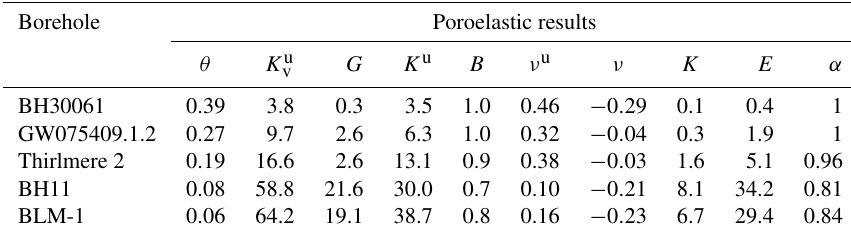
Table 4. Poroelastic results where θ is porosity (–), K u v is the vertical undrained bulk modulus, G is the shear modulus (GPa), K u is the undrained bulk modulus, B is Skempton’s coefficient (–), ν u is the undrained Poisson’s Ratio (–), ν is Poisson’s ratio (–), K is bulk modulus (GPa), E is Young’s modulus (GPa), and α is the Biot–Willis coefficient (–).